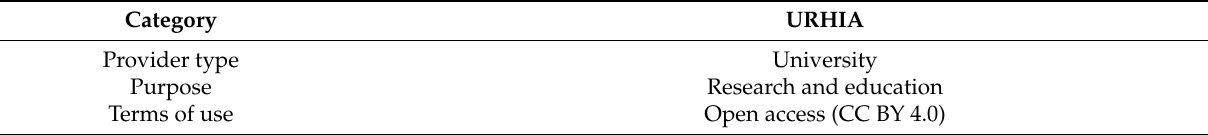
Table 6. Properties of the URHIA spatial data platform prototype.